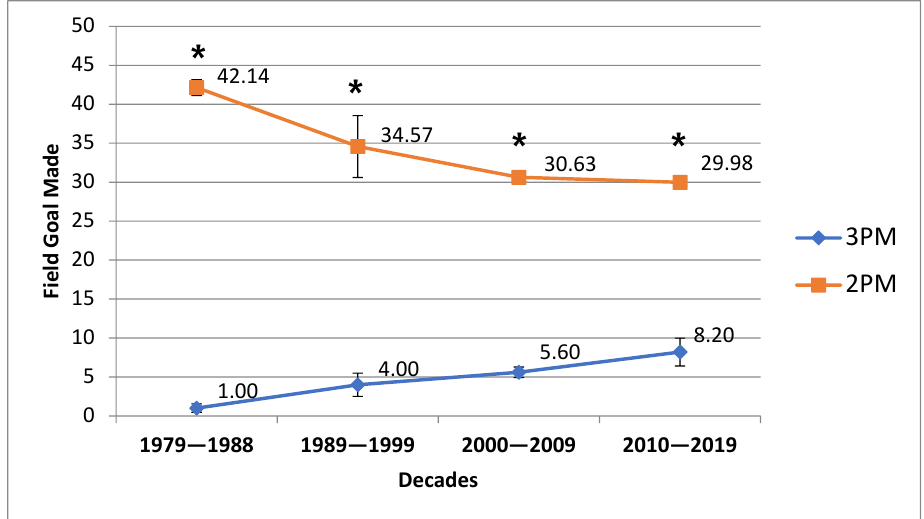
Figure 2. Trends in three-point and two-point field goals made over the last 40 NBA seasons. * Statistically significant compared with the previous decade with p < 0.05. One-way repeated-measures ANOVA revealed statistically significant differences between the analyzed decades for the 2PA and 3PA, 3PM variables. Similarly, the Fried- man test was used for 2PM. Table 2 presents the results of the ANOVA and Friedman tests and post hoc comparisons between decades for the mentioned variables.